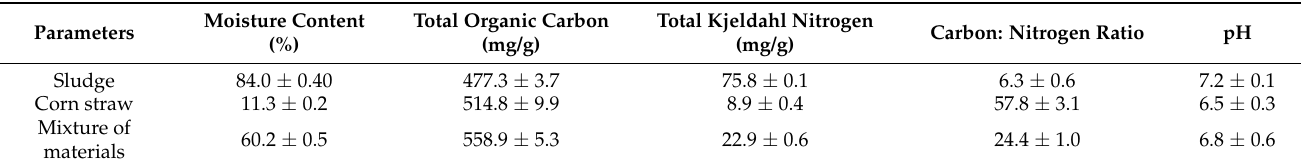
Table 1. Components of the composting